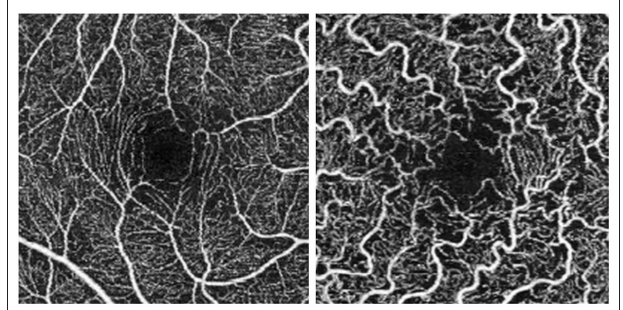
FIGURE 1 | Optical coherence tomography angiography (OCTA) 3 × 3 scans. Scan of the superficial capillary plexus in a healthy control (on the left) and in a patient with Fabry disease (on the